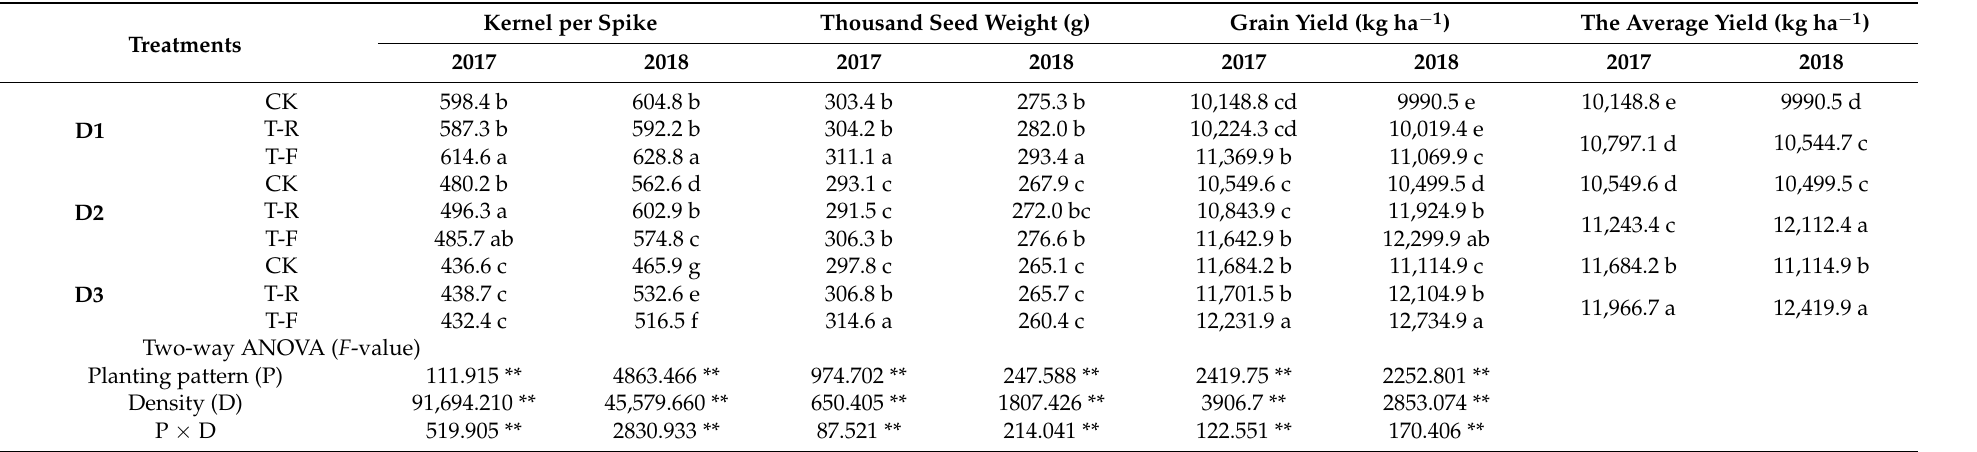
Table 2. Yield characteristics of maize in different planting